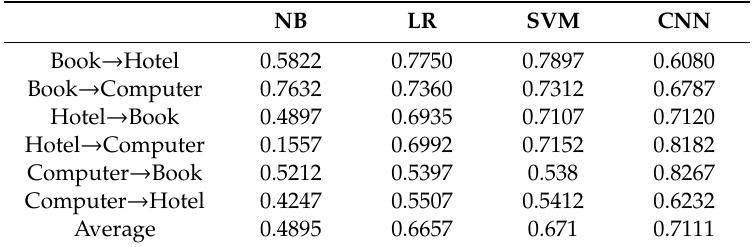
Table 5. Machine learning classification results.